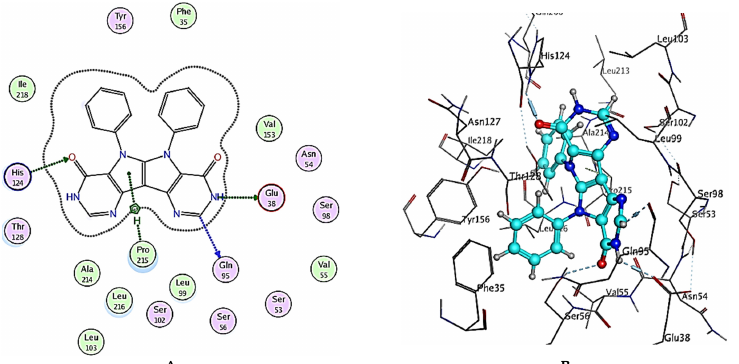
Figure 7. ( A ) Two-dimensional interactions and ( B ) three-dimensional interactions of compound 2 fitted into the binding site of NPC1L1 (pdb code: 3QNT) illustrating interactions with amino acid residues in the binding site.